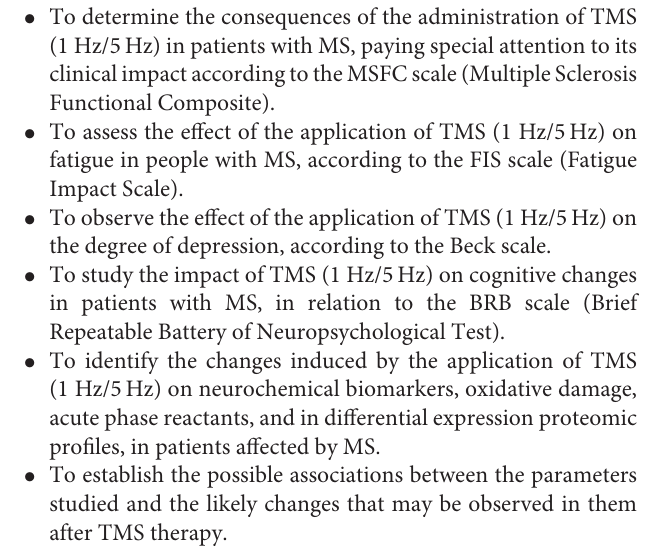
TABLE 1 | Inclusion and exclusion criteria for the study. Inclusion criteria Exclusion